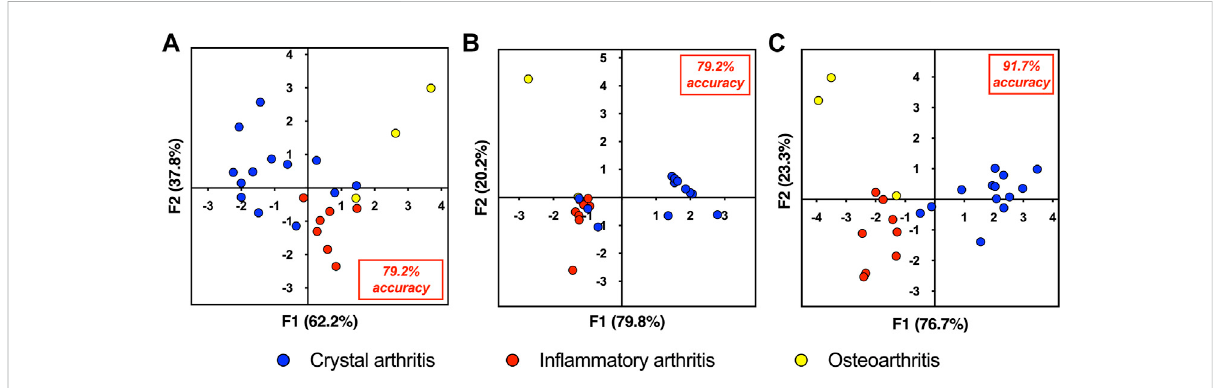
FIGURE 3 LDA score plots to discriminate between specimens with diagnoses of crystal arthritis ( n = 13), in fl ammatory arthritis ( n = 8) and osteoarthritis ( n = 3) s using blood test clinical data only (A) , synovial fl uid clinical data only (B) and synovial fl uid clinical data and MMP probe assay data (C)